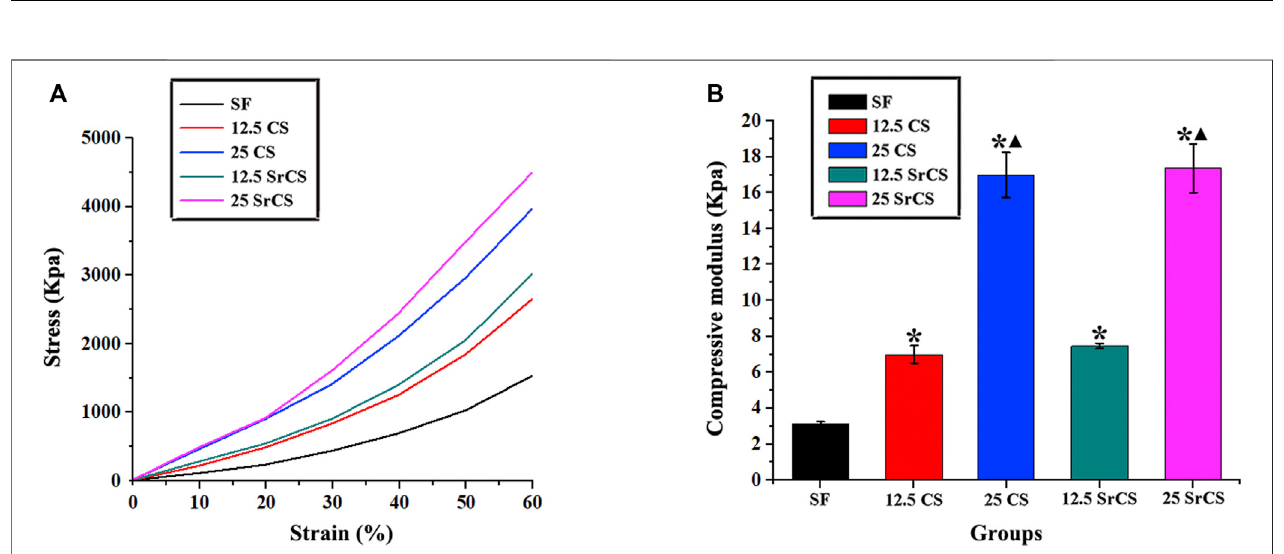
FIGURE 2 | Compressive mechanical properties of materials. (A) Stress – strain curve of materials. (B) Compressive modulus of materials at 10% strain. (SF: SF, 12.5 CS: 12.5 wt% CS/SF, 25 CS: 25 wt% CS/SF, 12.5 SrCS: 12.5 wt% SrCS/SF, 25 SrCS: 25 wt% SrCS/SF). The SF group was treated as the control group. * p < 0.05 indicates the other groups vs. the SF group. ▲ p < 0.05 indicates the 25 CS group or 25 SrCS group vs. the 12.5 CS group or 12.5 SrCS group.